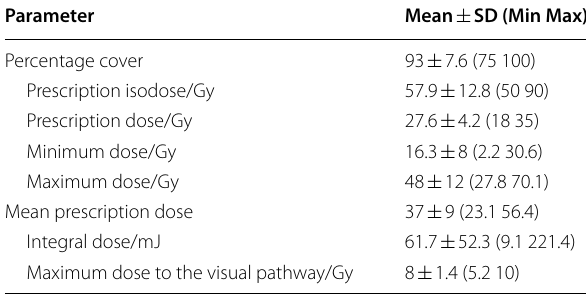
Table 3 Treatment